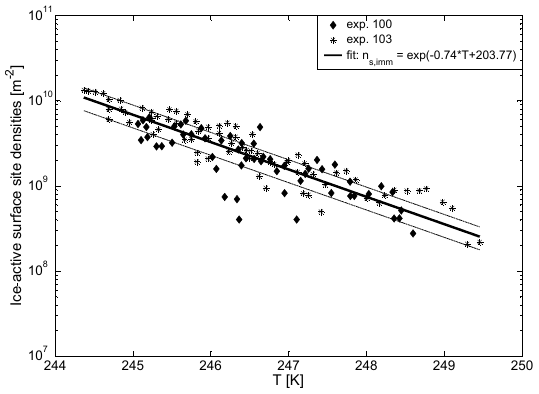
Fig. 7. Relation between temperature and the ice-active surface site densities in deposition nucleation mode n s , dep (for three ex- periments: • , H , F ) and, for comparison, the ice-active surface site densities in immersion freezing mode n s , imm ( (cid:7) ); lines are expo- nential fits to measured